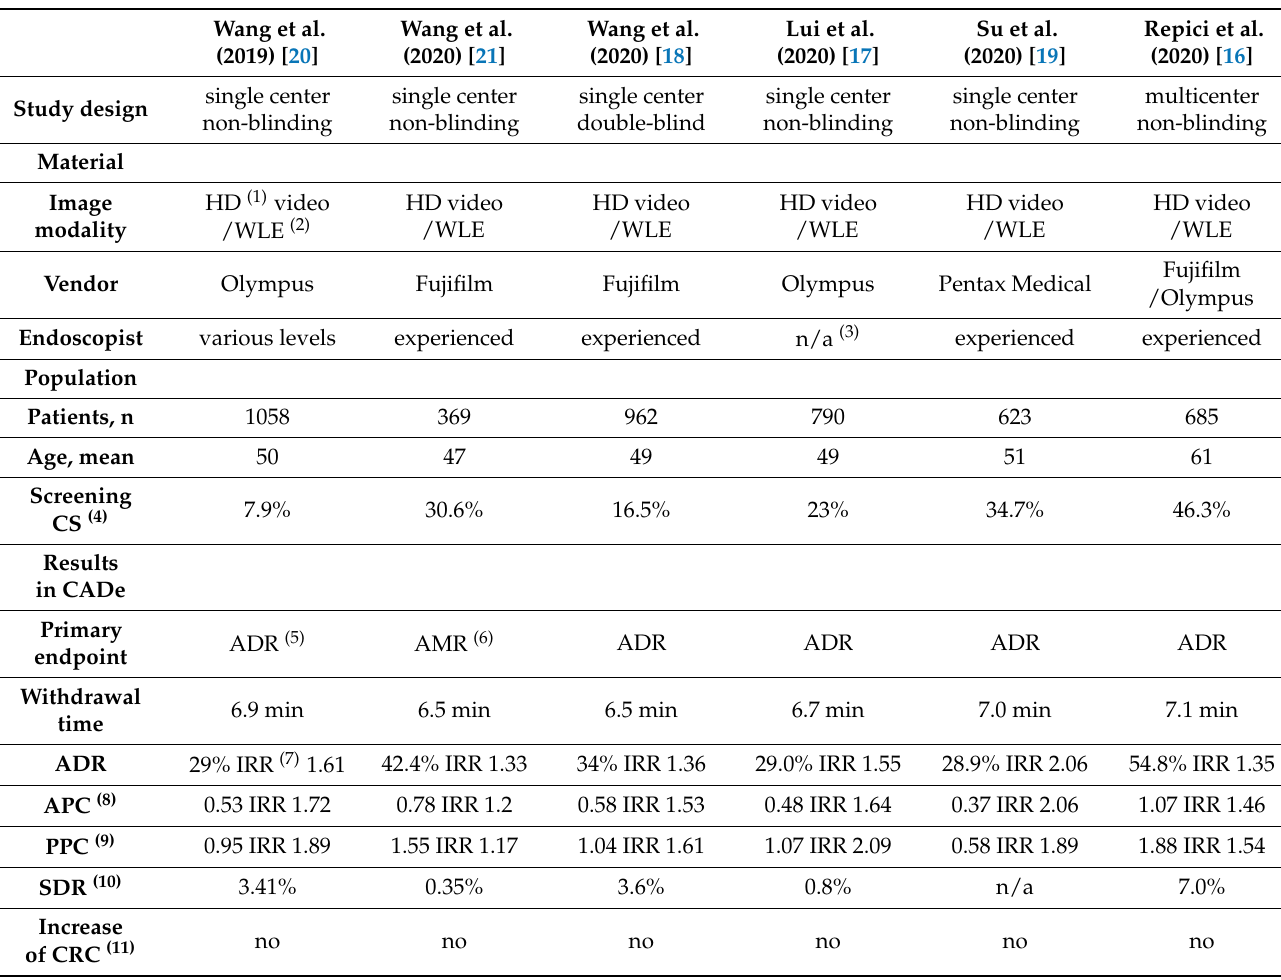
Table 1. Prospective randomized trial analyses in CADe